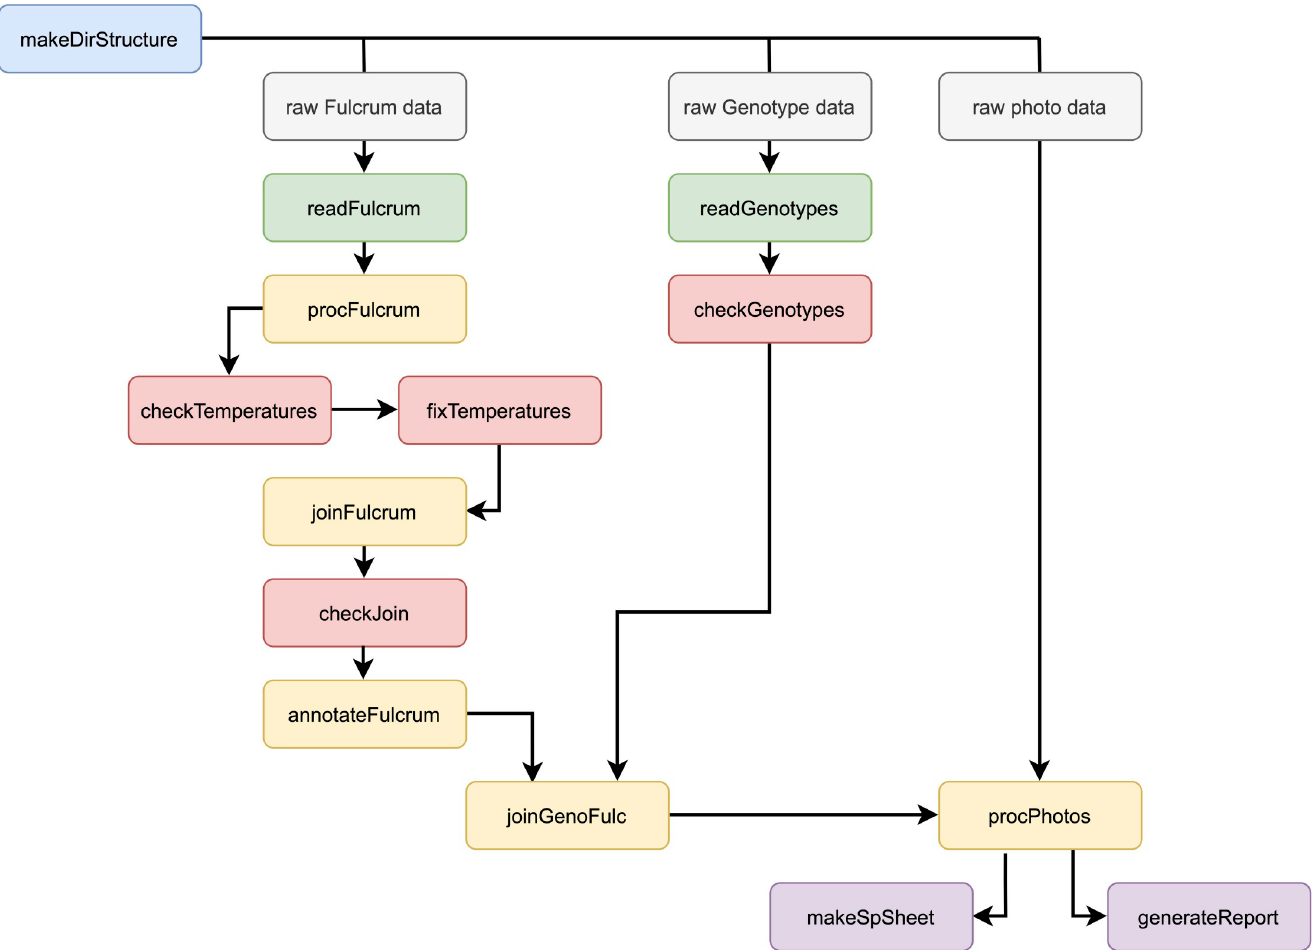
Fig 1. easyFulcrum workflow. The suggested workflow for processing a sampling project begins with making a project directory using the makeDirStructure() function (blue). The raw Fulcrum and photo data are exported from the Fulcrum database and loaded into the directory structure manually (grey). The raw genotype data is sourced directly from a Google sheet (grey). The workflow for read functions (green), processing functions (yellow), checking functions (red), and summarization functions (purple) is